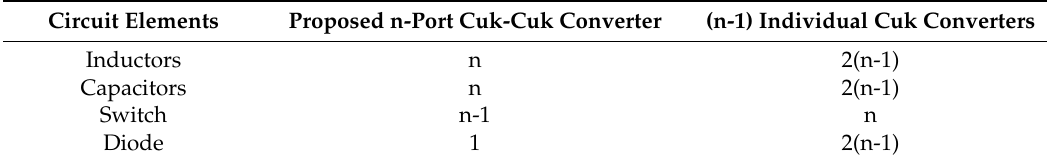
Figure 3. Generalized structure of the proposed ‘n’ port converter. Table 1. Comparison of circuit elements.